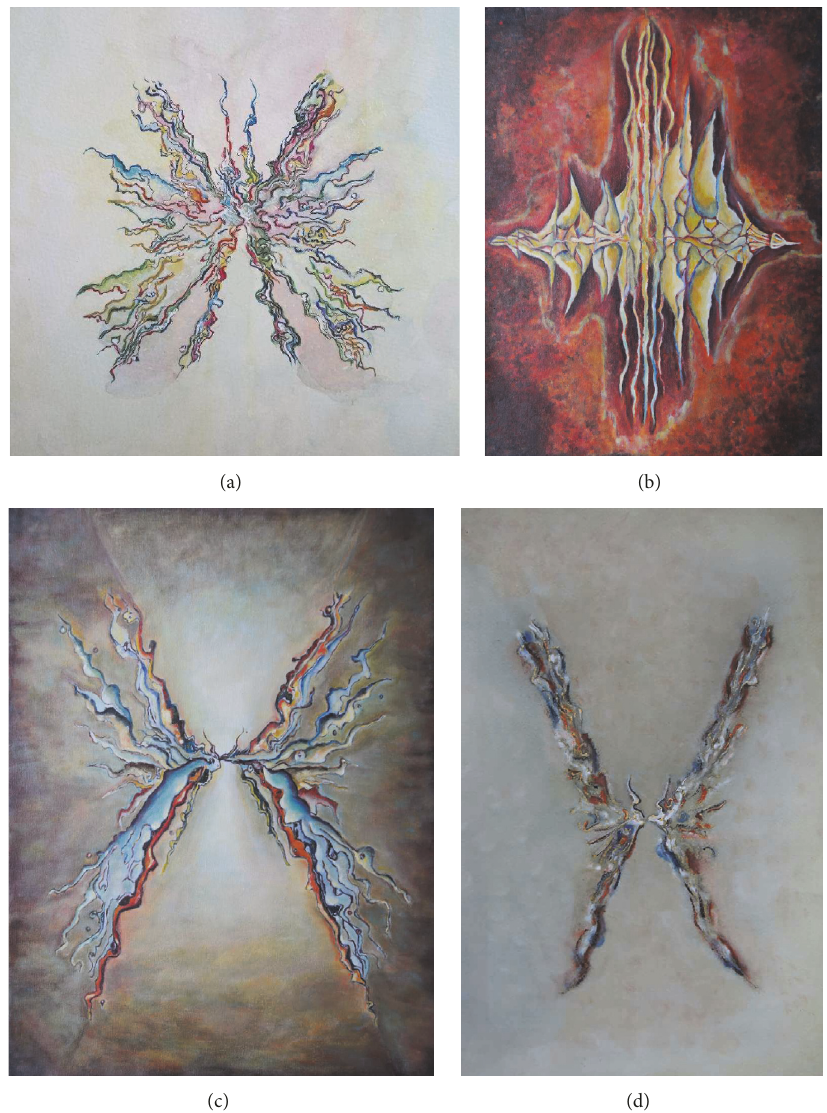
Figure 9: Photograph of four artistic works of artist Puri Pereira. (a) “Butterfly # 1” painted in acrylic, ink, and watercolor on paper of dimensions 30 × 40.5 cm. (b) “Fire on Water” painted in acrylic on canvas of dimensions 45.7 × 61cm. (c) “Butterfly # 2” painted in acrylic on canvas of dimensions 45.7 × 61cm. (d) “Birds” painted in ink, watercolor, and acrylic on paper of dimensions 30 × 40.5